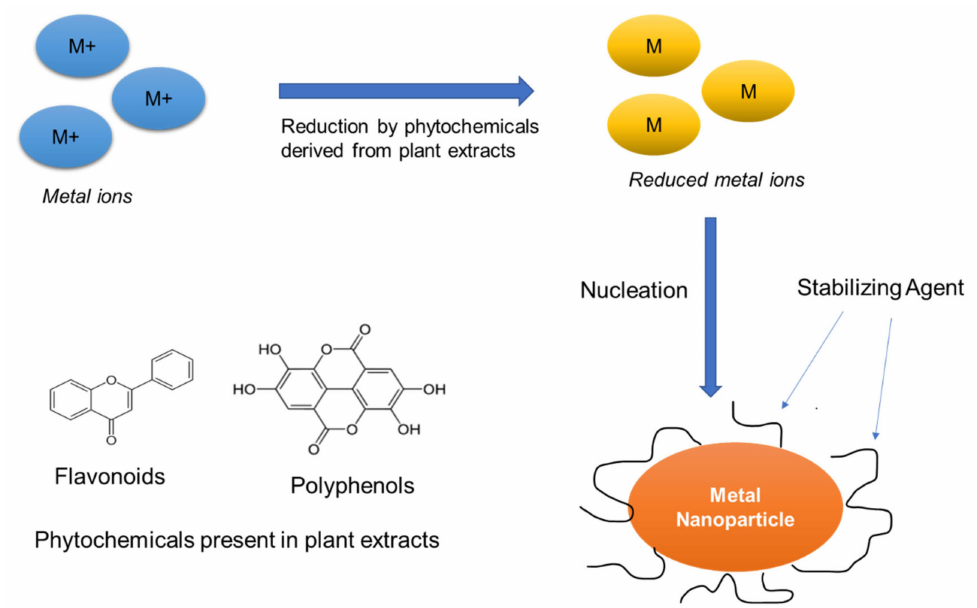
Figure 2. Simplified mechanism of formation of nanoparticles by extracts using plant